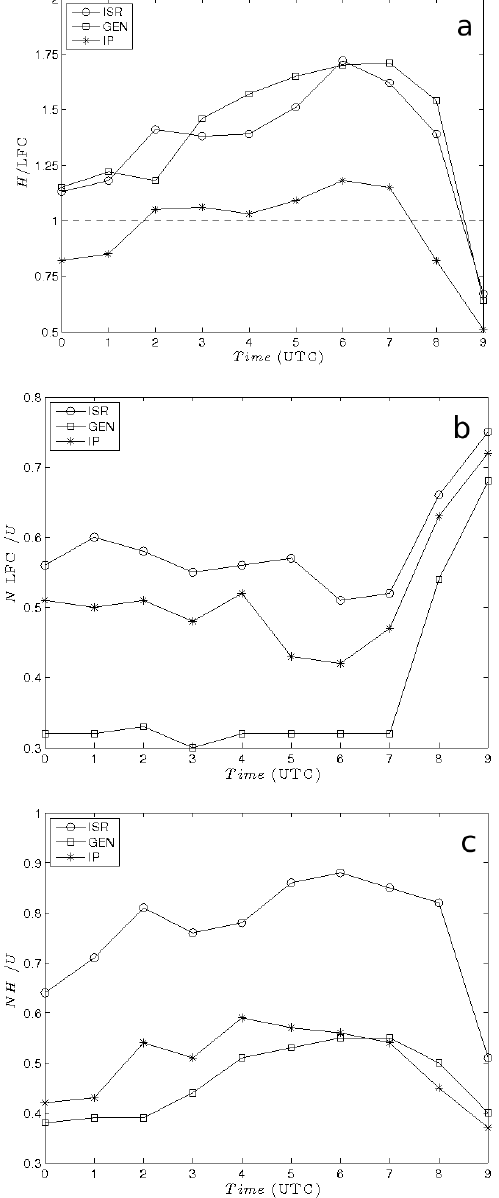
Figure 8. Temporal evolution from 00:00 to 09:00UTC of (a) the triggering parameter ( H /LFC), (b) the deceleration parameter ( N LFC/ U ), and (c) the blockage parameter ( NH / U ) for the ISR event on 6 January 2011 (circles), GEN event on 30 January 2008 (squares) and IP event on 6 September 2011